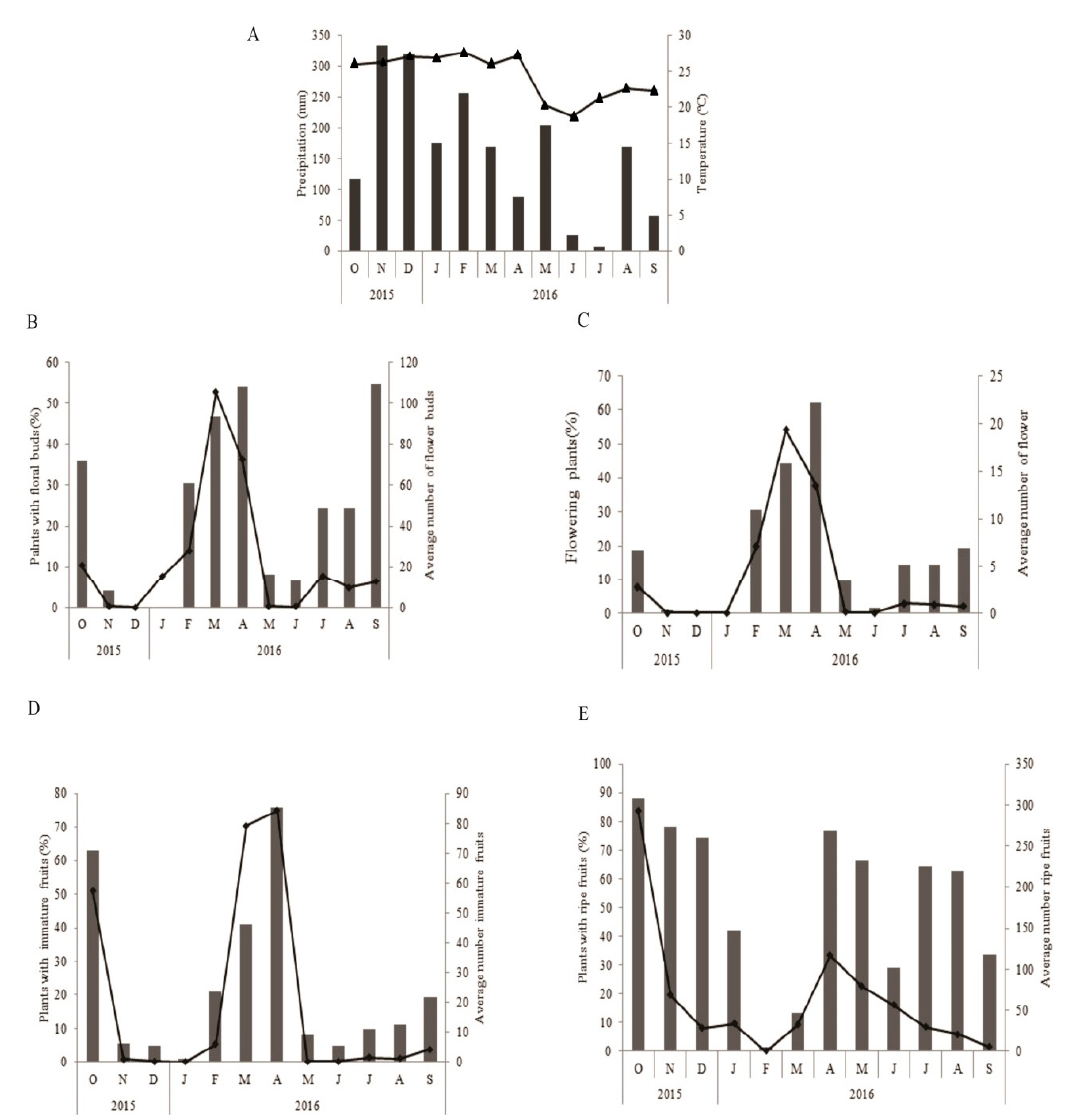
Figure 2. ( A – E ) Phenology of flowering and fruiting in Ludwigia nervosa from October 2015 to September 2016. ( A ) Climograph of Ivinhema, MS, during the period of phenological studies on a population of Ludwigia nervosa ; Precipitation (mm) (light bar); Temperature (°C) ( ▲ ). ( B – E ) Percentage of plants in which a phenological event was occurring (dark bar); Mean number of phenophases ( ◆ ).